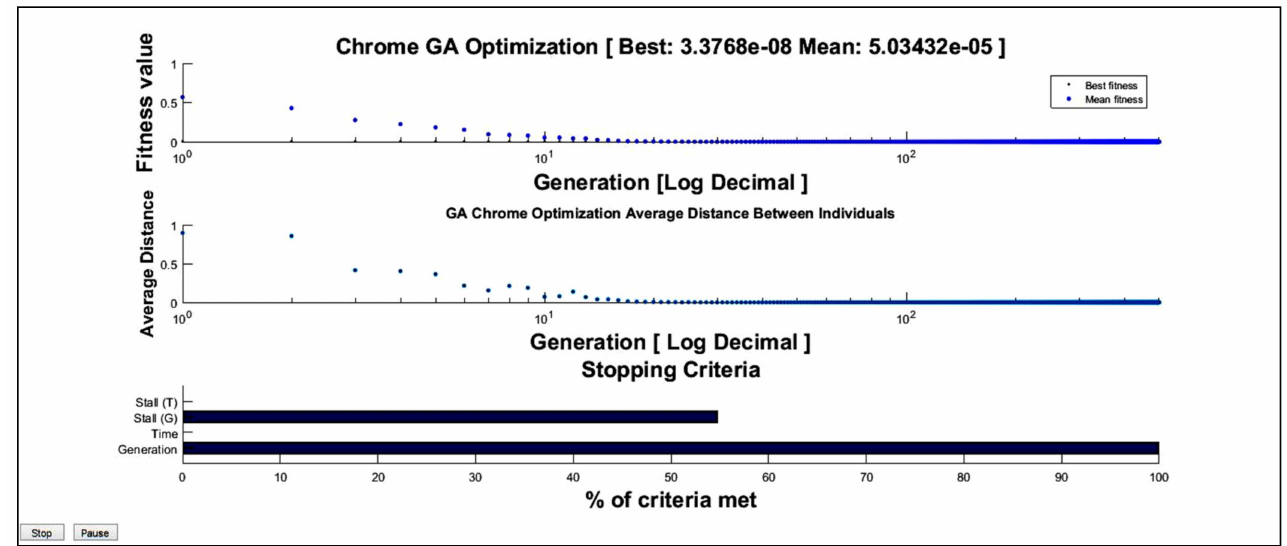
Figure 2. Chrome GA (first stage of optimization) combined chart results for best fit across generations (700). Best fit, average distance between individuals, and stopping criteria are shown. Results are accurate. Best Fit and Mean values are lower as it was selected 700 generations.